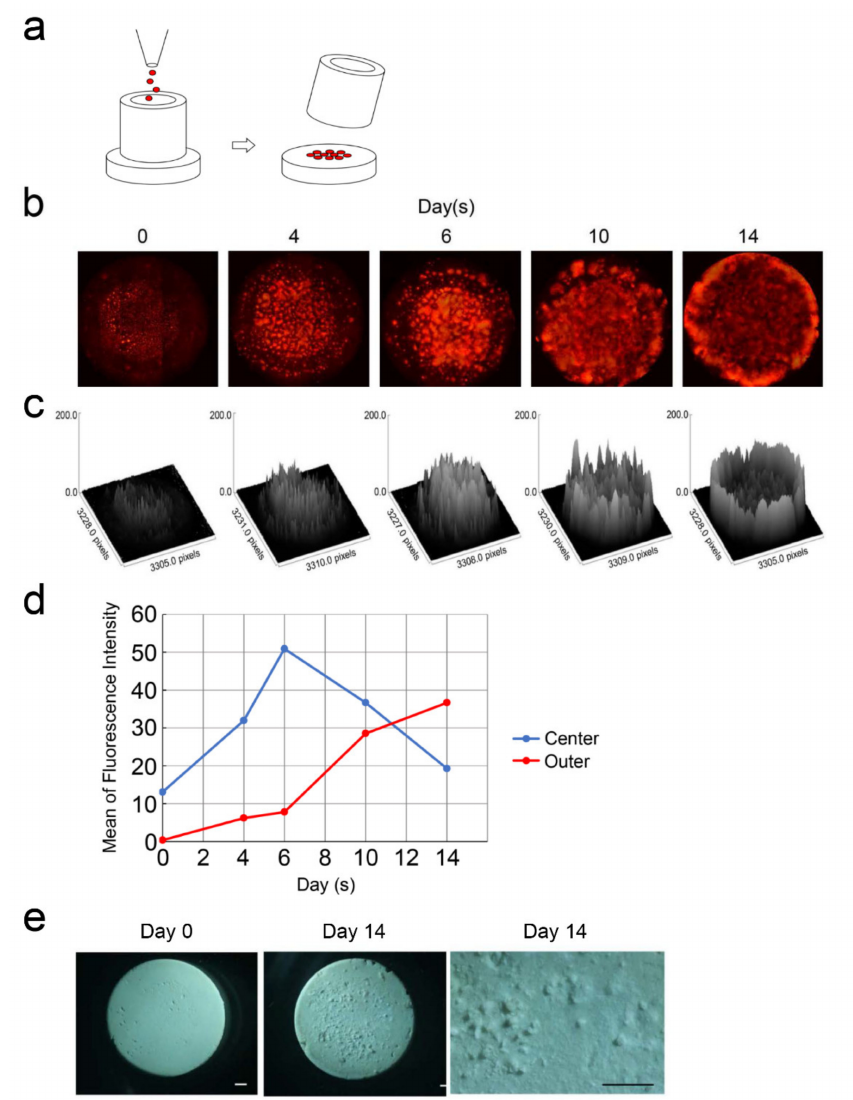
Figure 5. Chemotaxis of DsRed-PPU7 cells and mineralized precipitates on MTA disks. ( a ) Schema of DsRed-PPU7 cell seeding on MTA disks using a cloning cylinder. ( b ) Fluorescence microscope image of DsRed-PPU7 cells on MTA disks on Days 0, 4, 6, 10 and 14. ( c ) Three-dimensional images of fluorescence intensity of DsRed-PPU7 cells on MTA disk on Days 0, 4, 6, 10 and 14. ( d ) Changes in the fluorescence intensity of DsRed-PPU7 cells in the central or outer portion of MTA disks over time. ( e ) Stereomicroscope image of mineralized precipitates on MTA disks on Days (left) 0 and (middle) 14 and (right) a high-magnification image on Day 14 (scale bar: 1